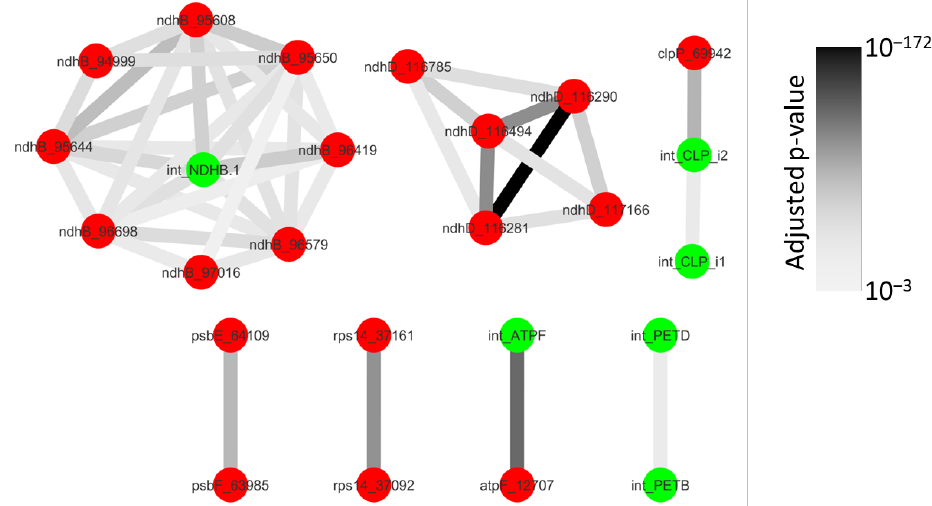
Figure 5. Network of splicing and editing coordination. Splicing events are shown in green and editing events in red. Dependent events are joined by an edge. The darkness of the edge is proportional to the adjusted p -value of the Exact Fisher test for the pool of the three replicates.